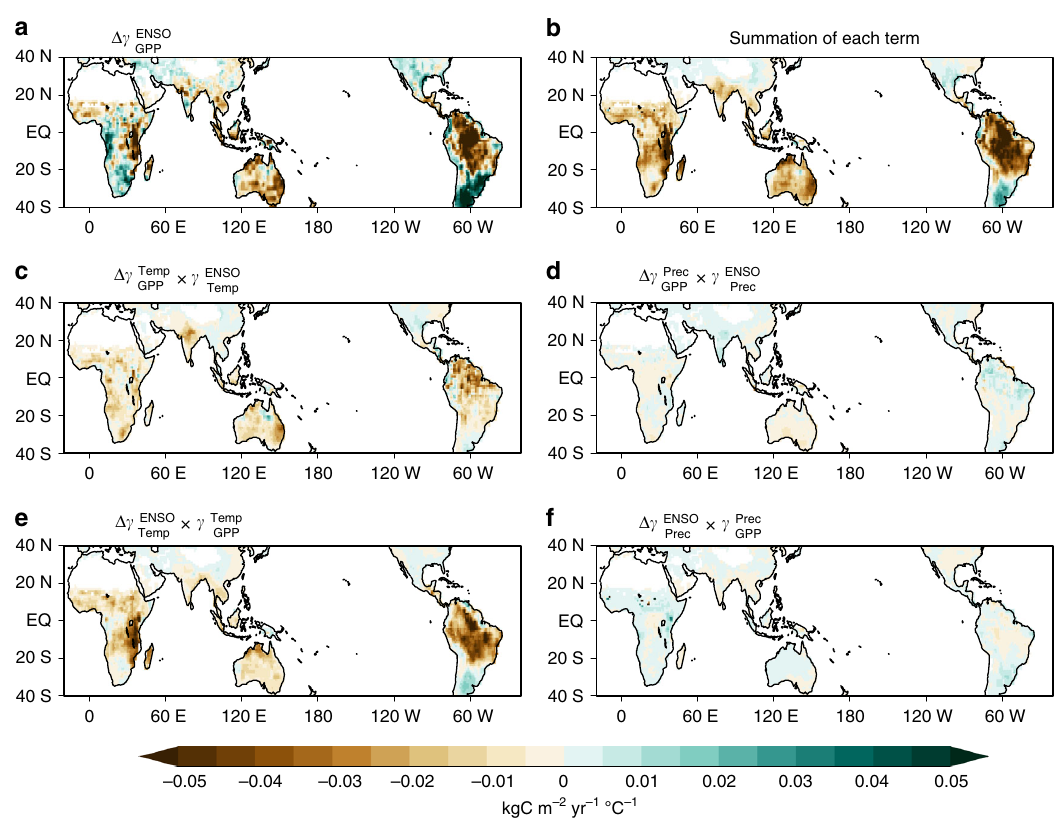
Fig. 2 Sensitivity contributions to enhanced gross primary production response to ENSO. a Differences in the regression coef fi cient of gross primary (cid:1) (cid:3) production (GPP) anomalies Δ γ ENSO from September to February for the December – February Nin ̃ o3.4 index between the preindustrial experiment and GPP ECP4.5. b Sum of changes in sensitivities based on each term in Eq. (4). c – f Each term in Eq. (4) plotted as a contribution to future changes in the